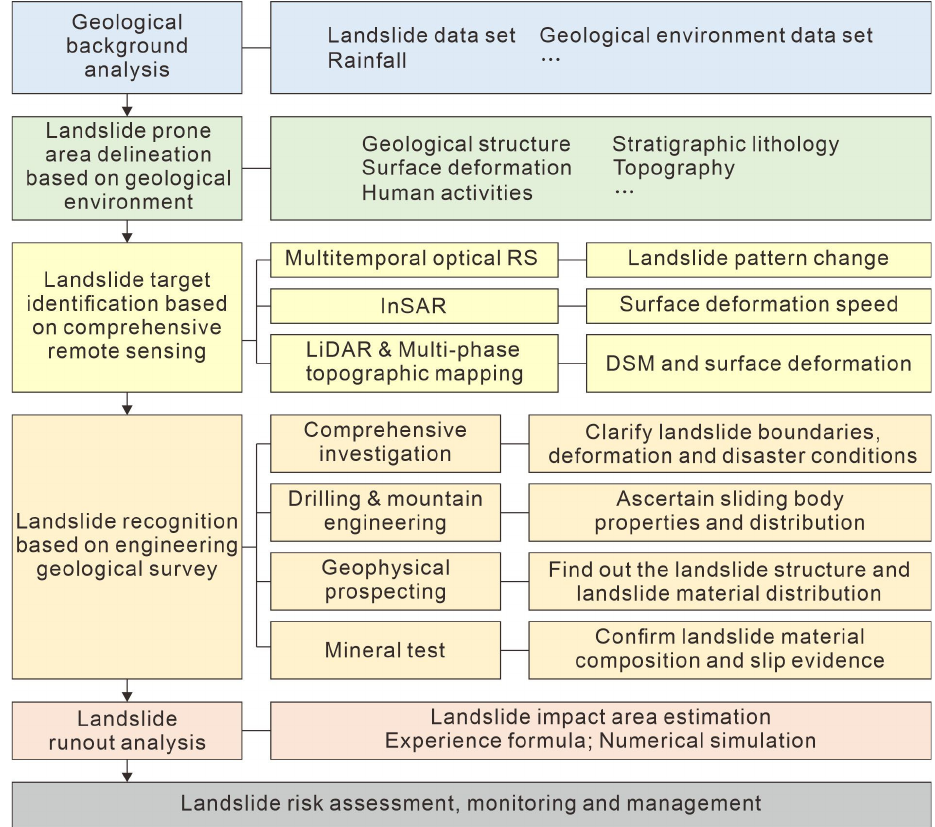
Figure 1. Landslide identification process in highly vegetation ‐ covered area.